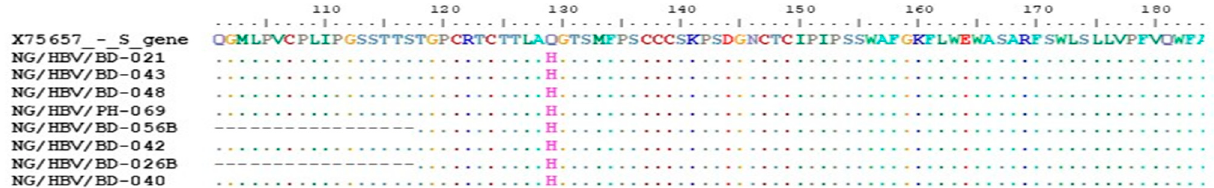
Figure 3. Partial HBs and Pol gene sequences obtained from this study aligned with the HBV genotype E reference sequence (Accession number X75657), showing the escape mutation at amino acid 129 of the S gene (sQ129H).